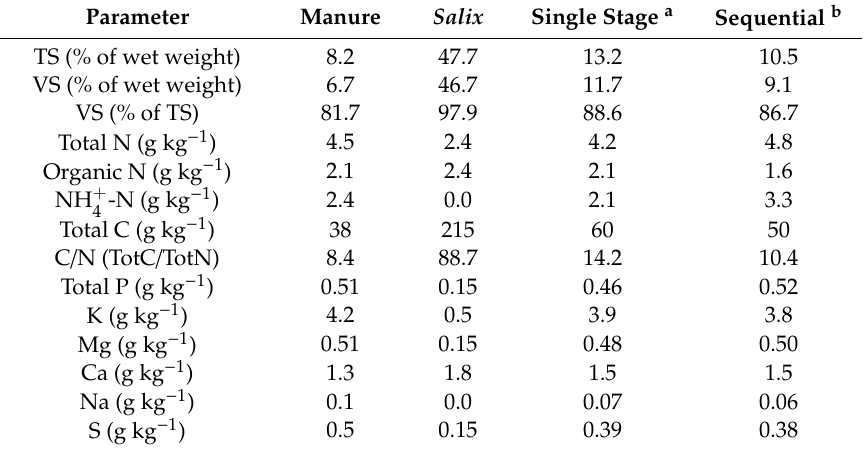
Table 2. The compositional parameters of substrates used in the single stage and sequential co-digestion experiments. TS: total solids; VS: volatile solids.